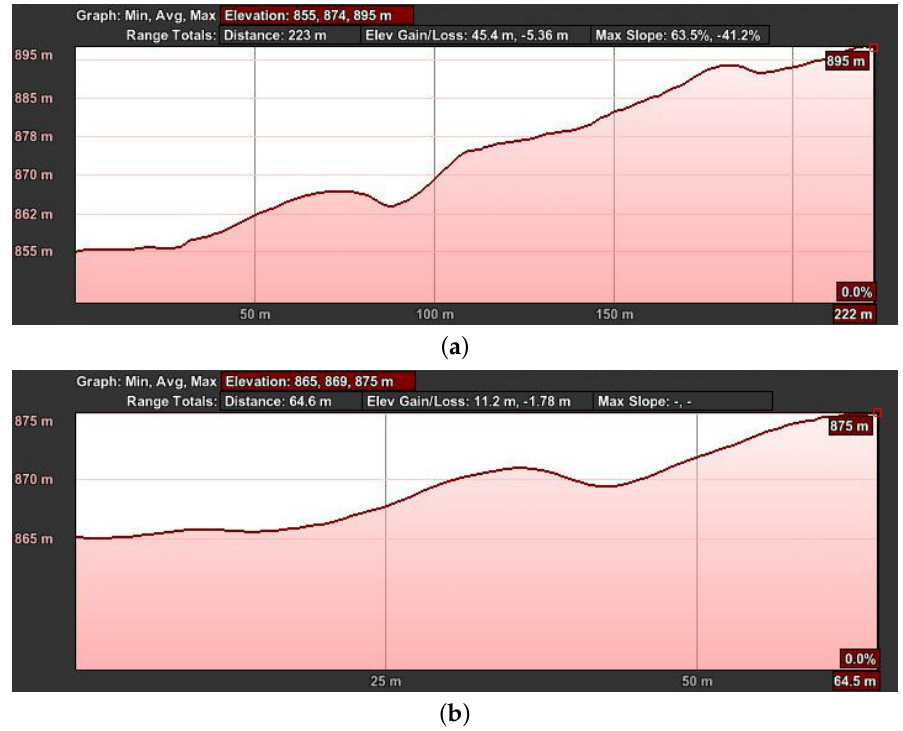
Figure 11. Hill flight path elevation from GPS data of the telemetry logs. The horizontal axis shows the distance the UAV has traveled, and the vertical axis represents the ASL altitude. These graphs were generated using Google Earth. ( a ) First part; ( b ) second